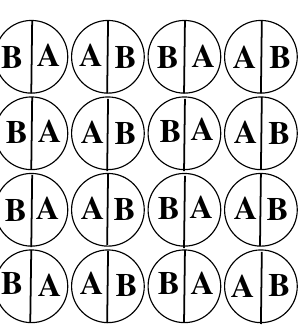
Figure 2. The structure of the stripped phase with two in-plane orientations of particles. The energy (per site) of this ordered structure at T = 0 is equal to